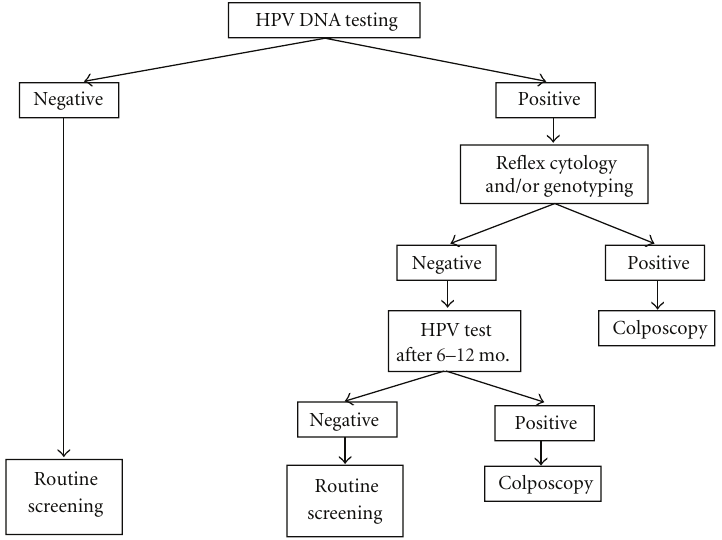
Figure 5: Schema for high-resource situations, starting with HPV DNA testing with reflex cytology and/or HPV